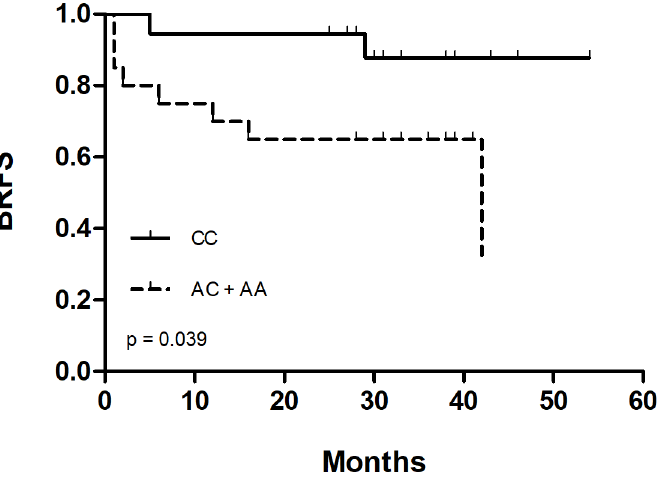
Fig 1. BRFS according rs6163( CYP17A1 ) genotype. Kaplan-Meier curves of time to biochemical recurrence in patients treated with radical prostatectomy and stratified by rs6163genotype( CC vs . AC+AA ).P value obtainedfrom log-rankt